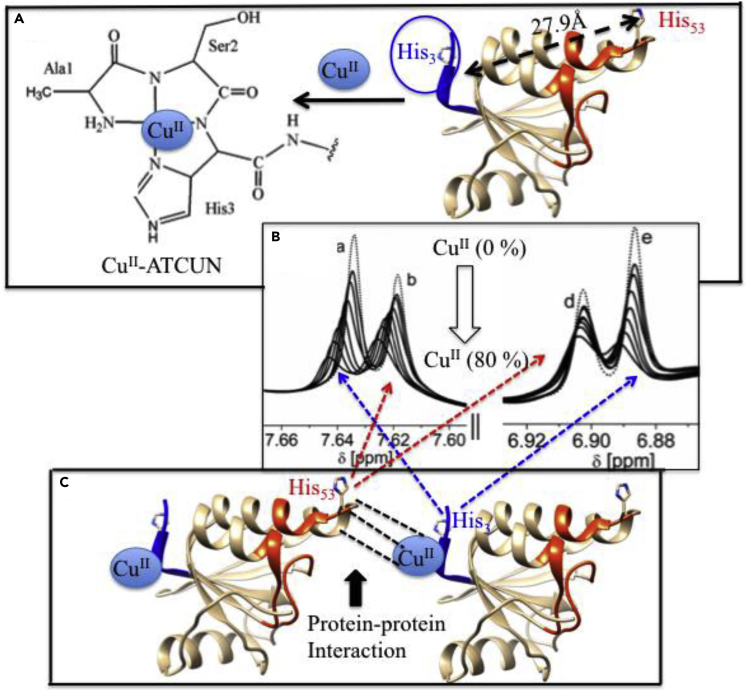
Application of Cu-ATCUNs as Paramagnetic NMR Reporters(A–C) (A) The paramagnetic NMR probe, CuII-ATCUN is attached at N-terminus of ORP. The crystal structure of apo-ATCUN-ORP is derived from PDB 2WFB (Najmudin et al., 2009), (B) Paramagnetic 1H-NMR spectrum (600 MHz) of apo-ATCUN-ORP is titrated with CuII salt (0–80%) in mixture of 50 mM Tris-HCl at pH 7.6/D2O (80/20%) and only His53 (b and d peaks) and His3 (a and e peaks) amino acid redidues are represented those are highly affected, and (C) Schematically shows the protein-protein interaction in head-tail fashion (dotted black lines). Modified from , Maiti et al., 2017b.